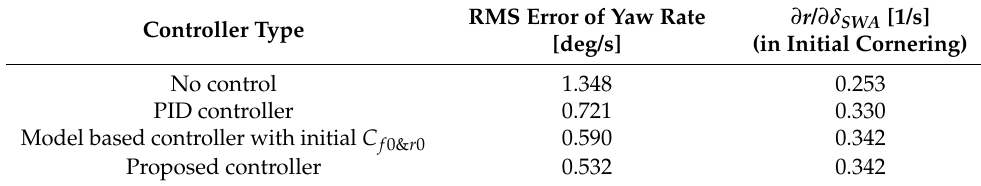
Table 2. Comparison of controllers (simulation results).